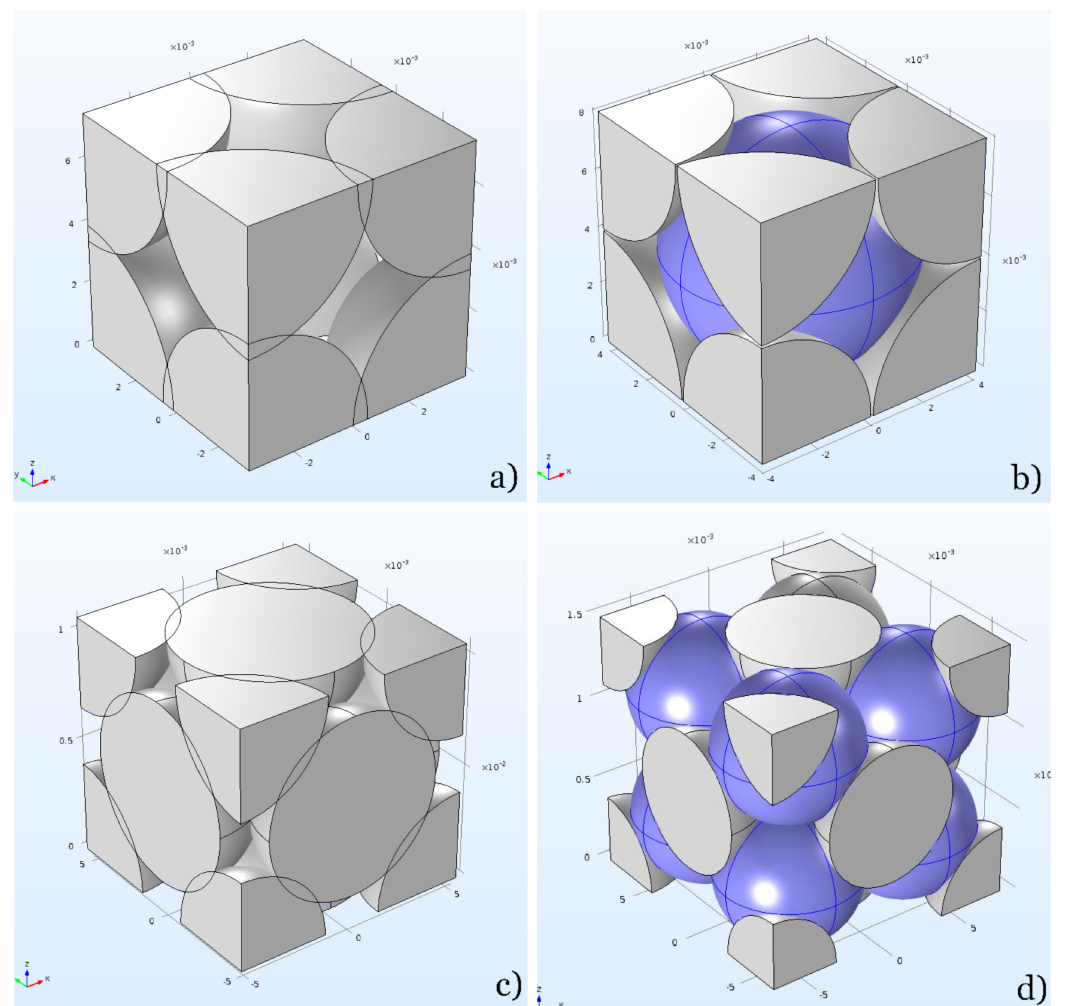
Figure 2. Structures investigated in the present work (overlapping case): ( a ) SC (Simple Cubic), ( b ) BCC (Body-Centred Cubic), ( c ) FCC (Face-Centred Cubic), ( d ) Tetragonal (mono-sized CaF 2 ). For BCC and Tetragonal structures, the overlapping occurs first between internal (blue-coloured) and external